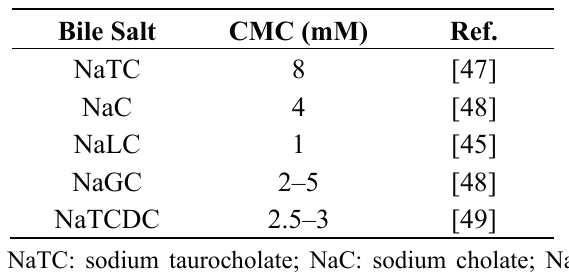
Table 3. CMC value of some bile